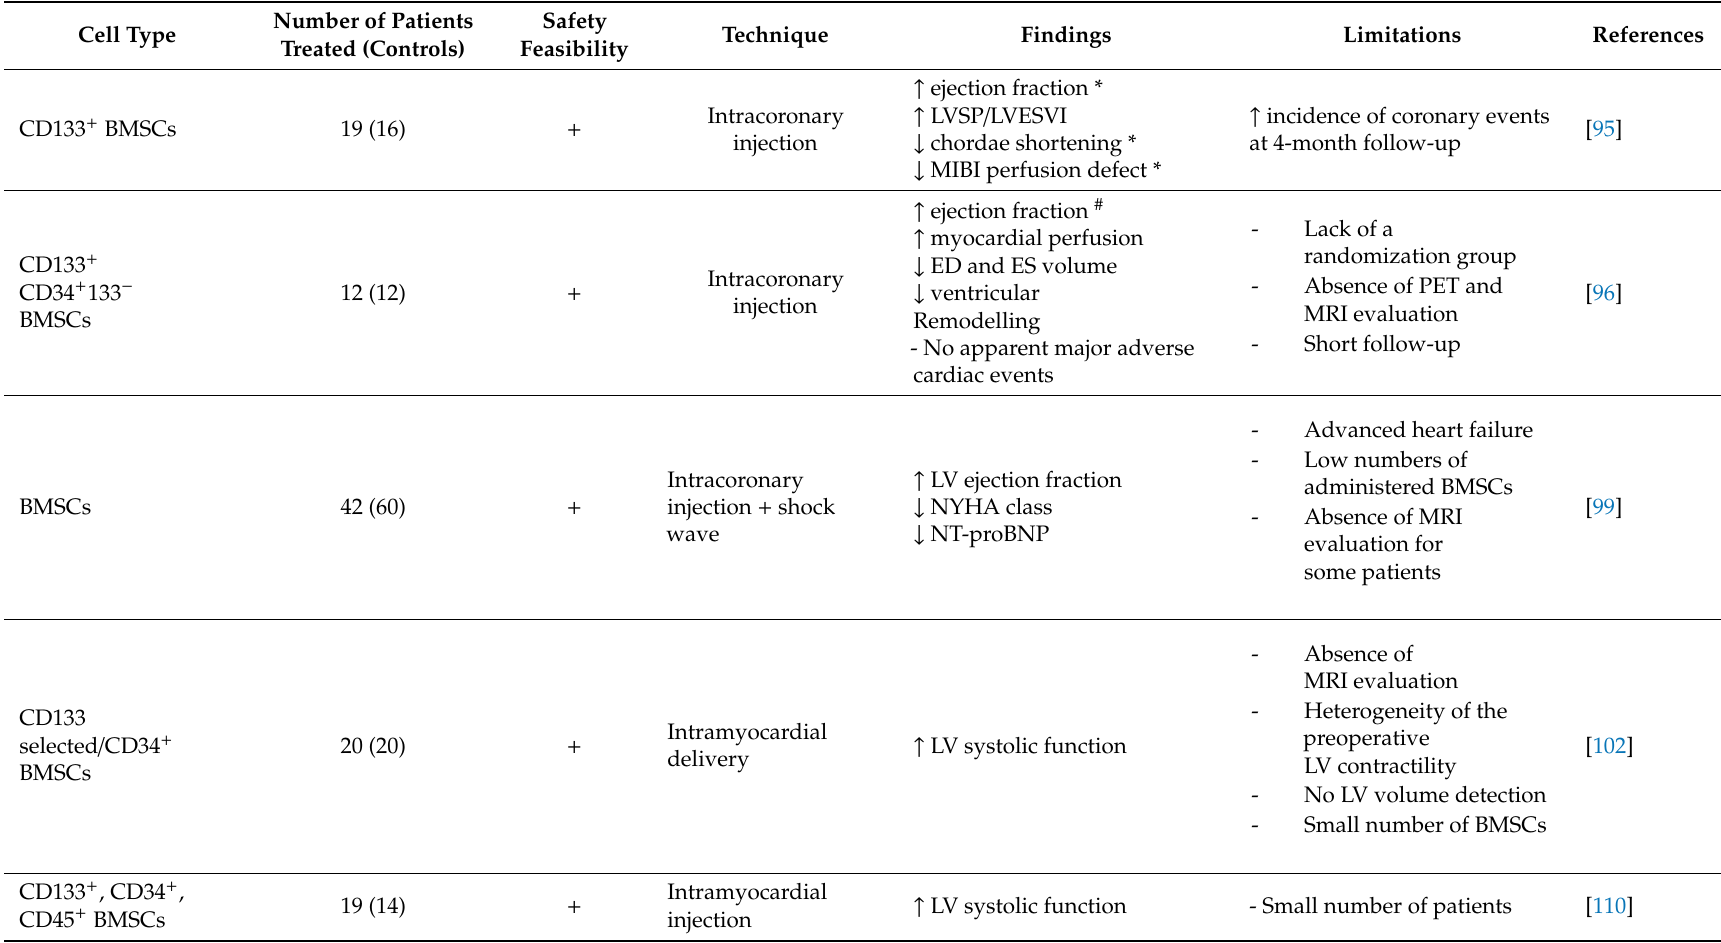
Table 1. Clinical trials for regenerative medicine in cardiovascular ischemic diseases employing